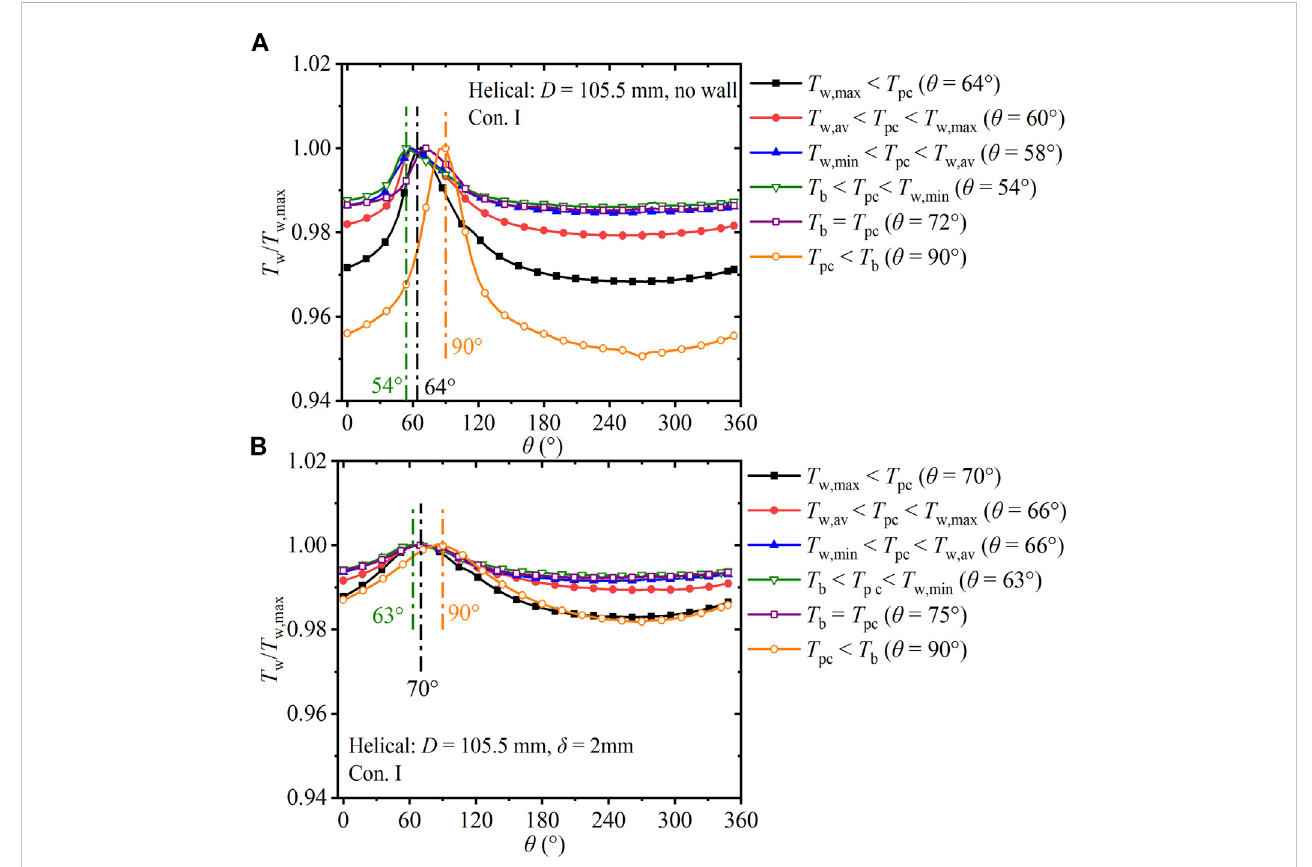
FIGURE 9 Development of circumferential T w / T w,max in the helical tube versus θ ( D = 105.5 mm, Con. I: G in = 225